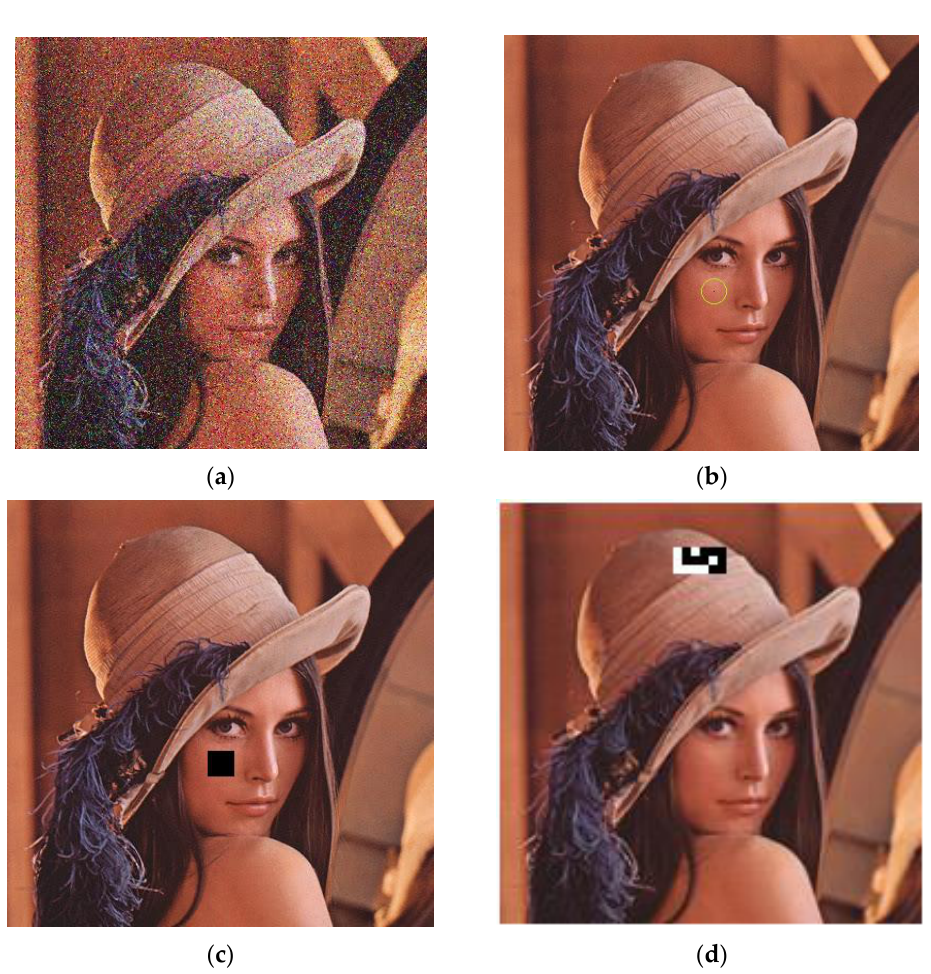
Figure 3. Images that have been visually attacked using different attack types: ( a ) Attack No. 1; ( b ) Attack No. 2; ( c ) Attack No. 3; and ( d ) Attack No. 4.